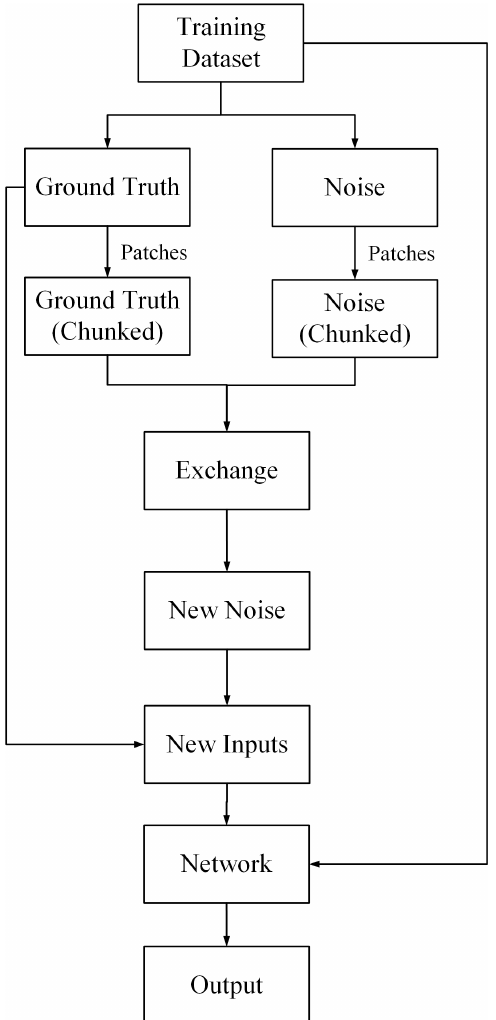
Figure 2. The flow of the entire algorithm is shown in the figure above. The data in the training set are stored in the form of noisy–clear image pairs. First, the two images are chunked, and then the corresponding patches are exchanged to generate a new noisy image. After that, the newly generated noisy image and the previous clear image form a new set of image pairs, which are put into the network for training at the same time as the image pairs in the original